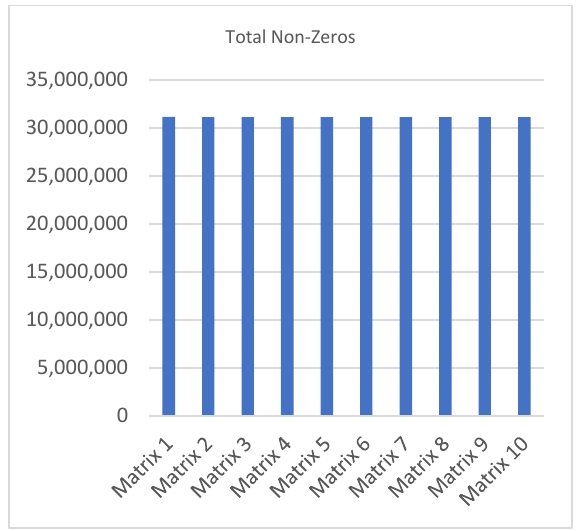
Figure 3. Total zon-Zeros.